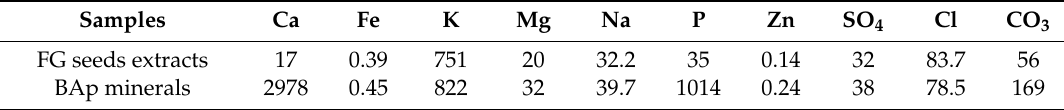
Table 1. Chemical analysis of fenugreek seed extract and biosynthesized BAp powders in mg / L. Samples Ca Fe K Mg Na P Zn SO 4 Cl CO 3 FG seeds extracts 17 0.39 751 20 32.2 BAp minerals 2978